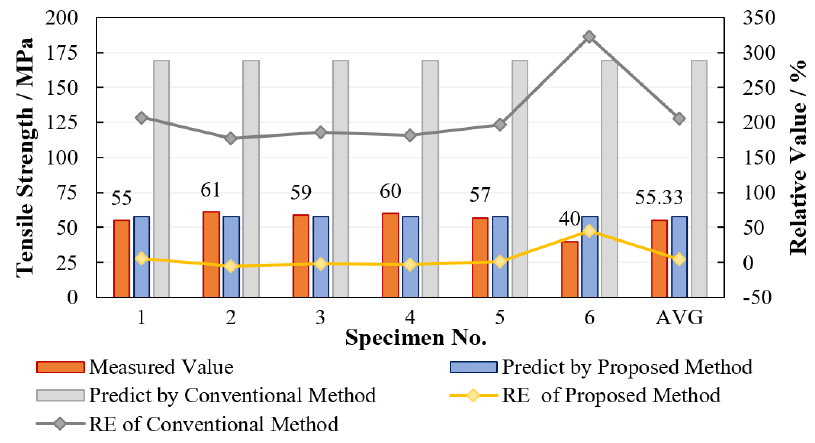
Figure 5. Displacement vs. transverse tensile force curves for six UD CFRP specimens.